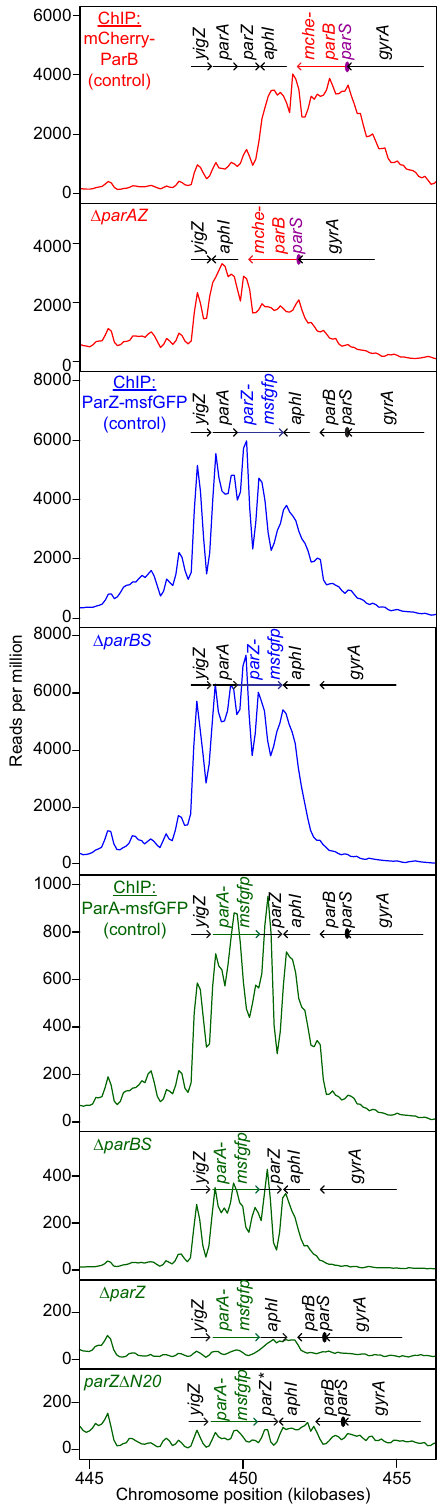
Fig. 6 | B. burgdorferi ParB, ParZ, and ParA bind to the par locus. ChIP-seq pro fi les showing the binding of mCherry-ParB (red traces), ParZ-msfGFP (blue traces), or ParA-msfGFP (green traces) to the par region of the B. burgdorferi chromosome in the indicated strain backgrounds. Strains used, from top to bottom, are: CJW_Bb379, CJW_Bb525, CJW_Bb378, CJW_Bb524, CJW_Bb488, CJW_Bb520, CJW_Bb519, and CJW_Bb610. Genes underlining the enriched sequence reads are highlighted. aphI , kanamycin resistance gene introduced during strain